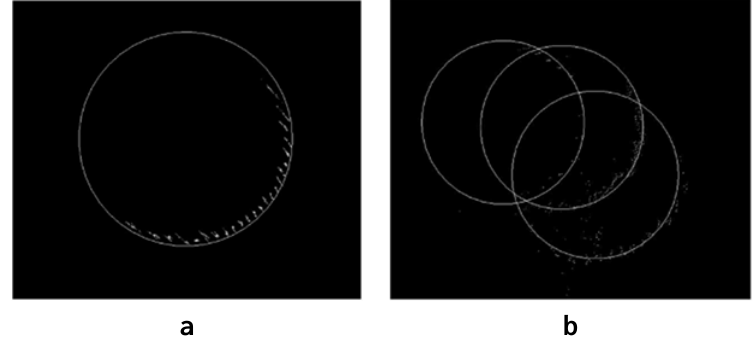
Figure 3. Fitting a circle around the stem points of the MLS (Mobile Laser Scanning) reference ( a ) and same tree stem scanned from different locations with MLS showing the positioning error ( b ).